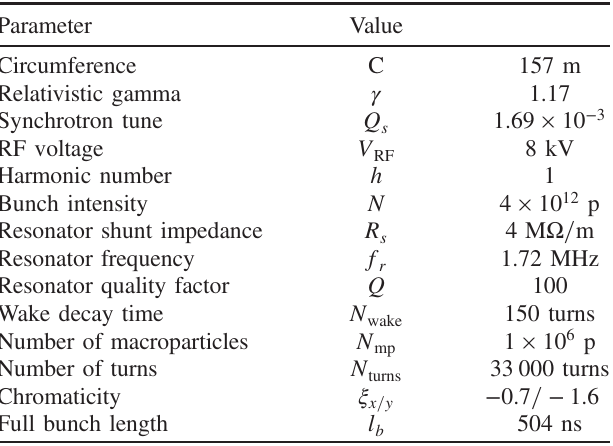
TABLE I. Main parameters used in P y HEADTAIL